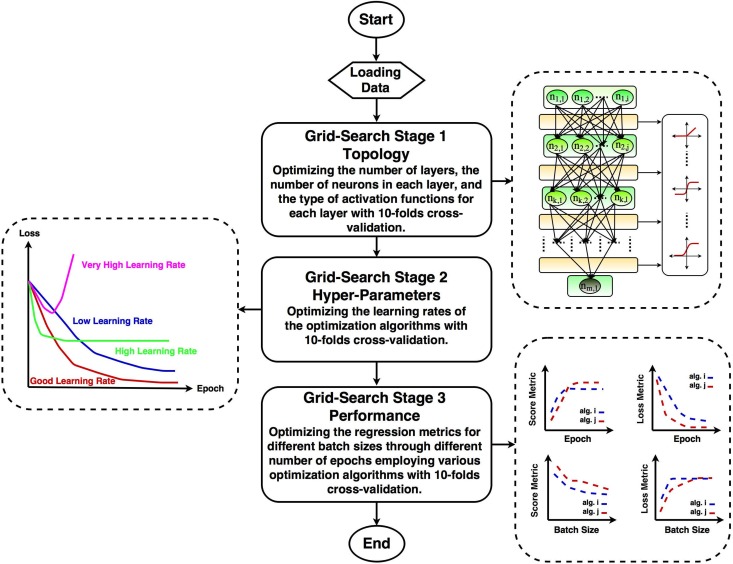
iDeepLe flowchart.